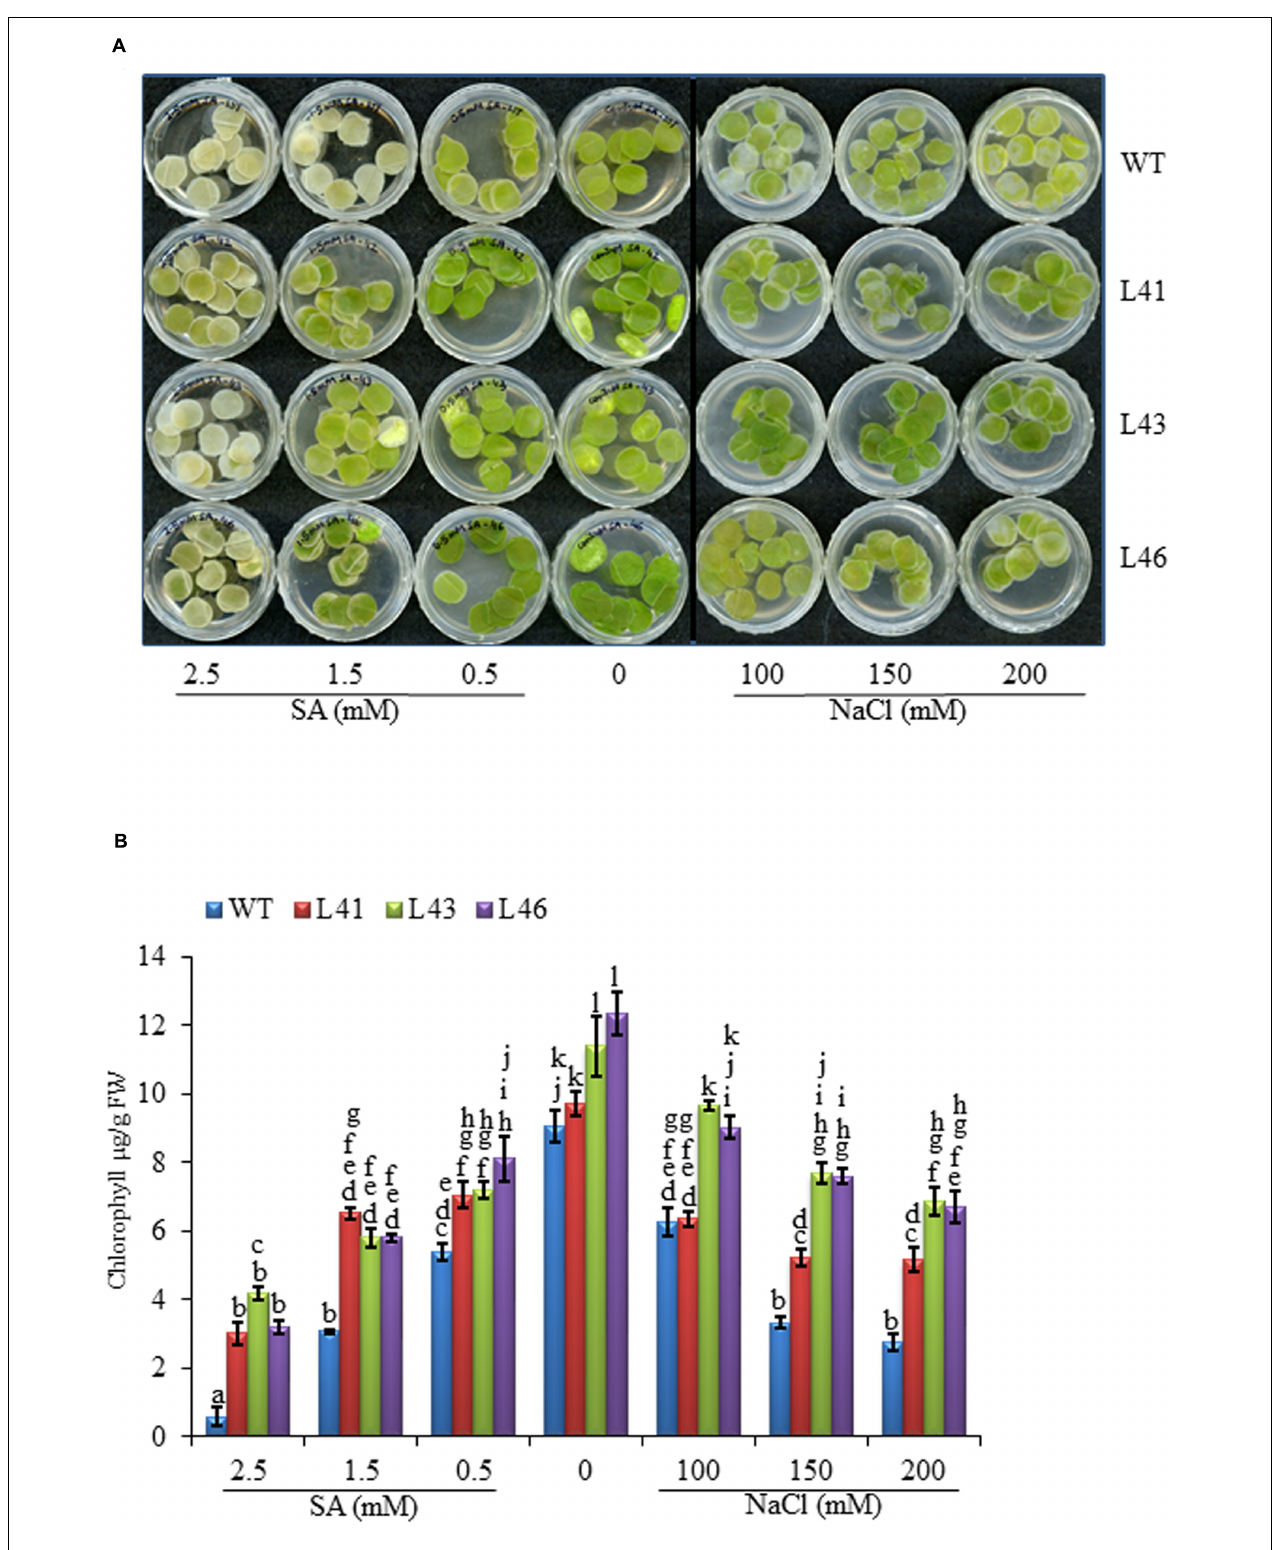
FIGURE 2 | (A) Leaf disk assay of WT and T 0 transgenic lines (L41, L43, and L46) at different concentrations of NaCl (0, 100, 150, 200 mM) and SA (0.5, 1.5, 2.5 mM). (B) Chlorophyll analysis at different SA and NaCl concentrations. Values are represented as mean ± SD ( n = 3) and marked with different alphabets to indicate significant difference at P ≤ 0.05